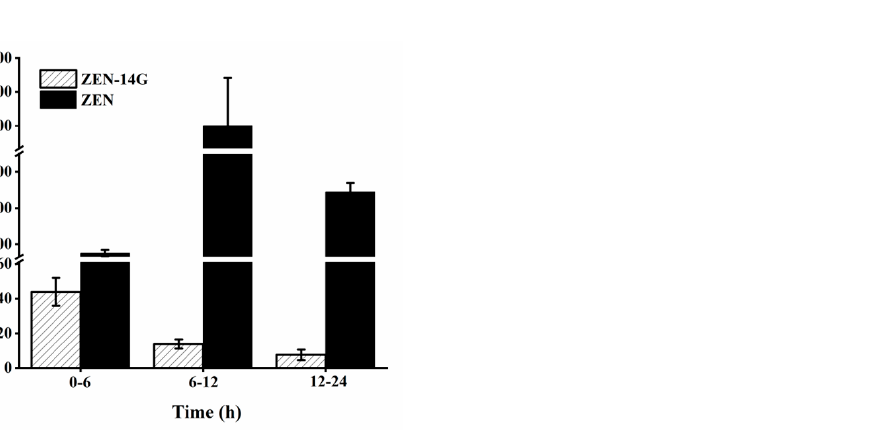
11 of 16 Figure 4. Tissue distribution of zearalenone-14-glucoside (ZEN-14G) and its metabolite, zeara- lenone (ZEN), in rats (dose of 4 mg/kg body weight, n = 3). Both ZEN-14G and its metabolite, ZEN, were detected in the urine (Figure 5). The amounts of urinary ZEN-14G were low and showed a decreasing trend at concentration levels from 43.9 ± 11.1 µg/L to 7.6 ± 3.0 µg/L within 24 h. These results were consistent with our data in plasma showing that ZEN-14G could be absorbed directly into the plasma in small amounts. Compared with ZEN-14G, ZEN maintained relatively higher